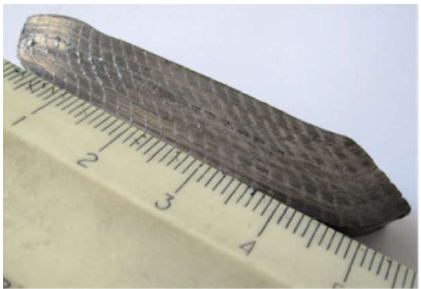
Figure 1. A picture of ECAP processed billet shows transformation of a reference square array drawn on the four 50 × 10 mm faces at the initial state.